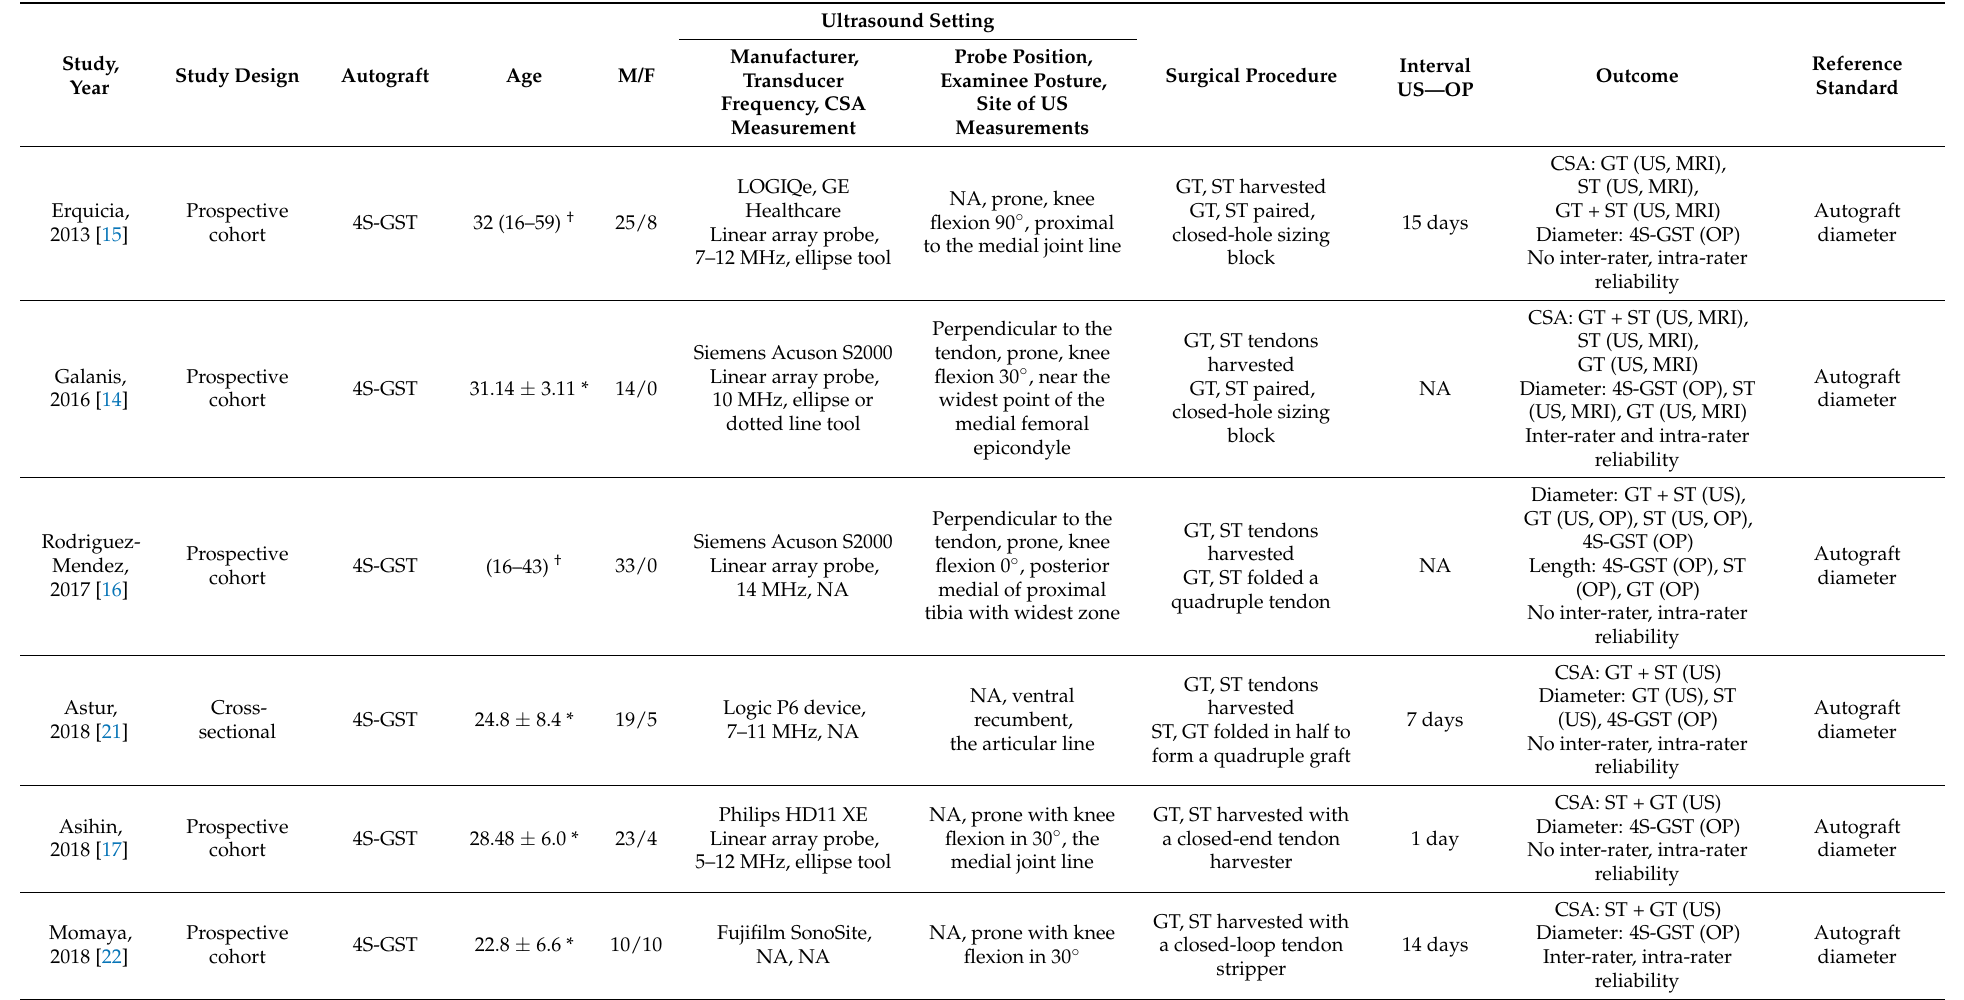
Table 1. Summary of the retrieved studies investigating the predictive values of ultrasound imaging for autograft size in anterior cruciate ligament